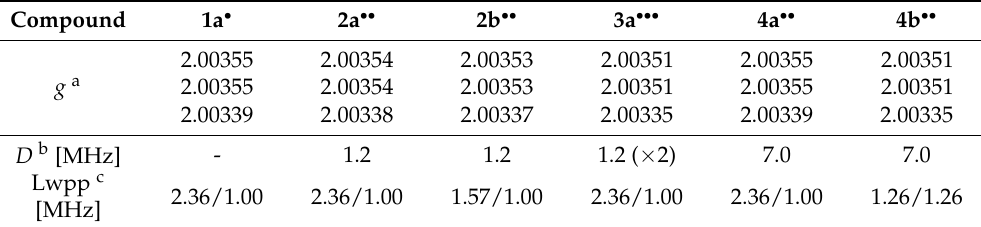
Table 2. Simulation parameters for the frozen solution EPR spectra (T = 120 K) of 1a • – 4b •• .